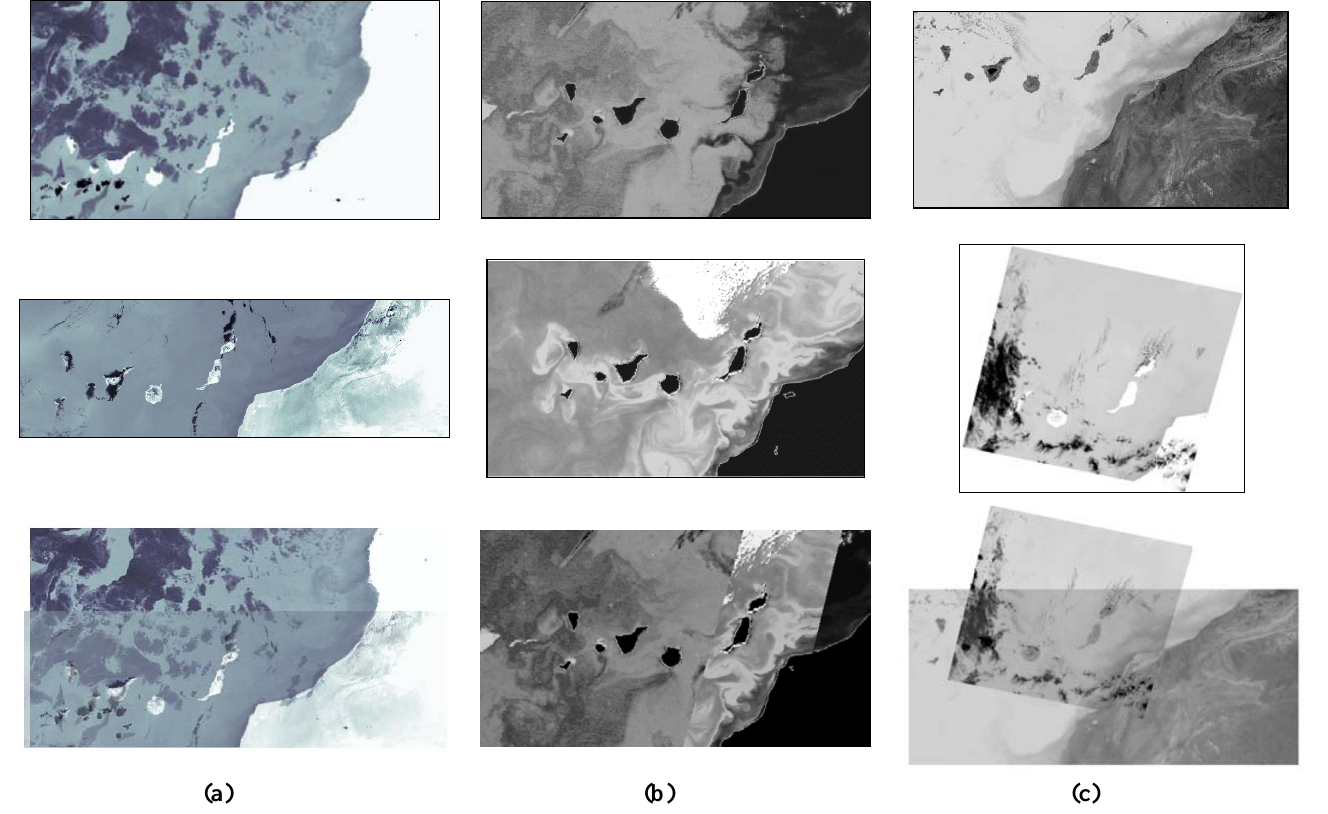
Figure 6. Results of contour-based approach applied to multitemporal/multisensorial image registration: (a) Multitemporal SST images from NOAA-AVHRR sensor, (b) multisensorial SST and ocean color images from AVHRR and SeaWiFS sensors, and (c) multisensorial SST images from AQUA-MODIS and ERS/2-ATSR